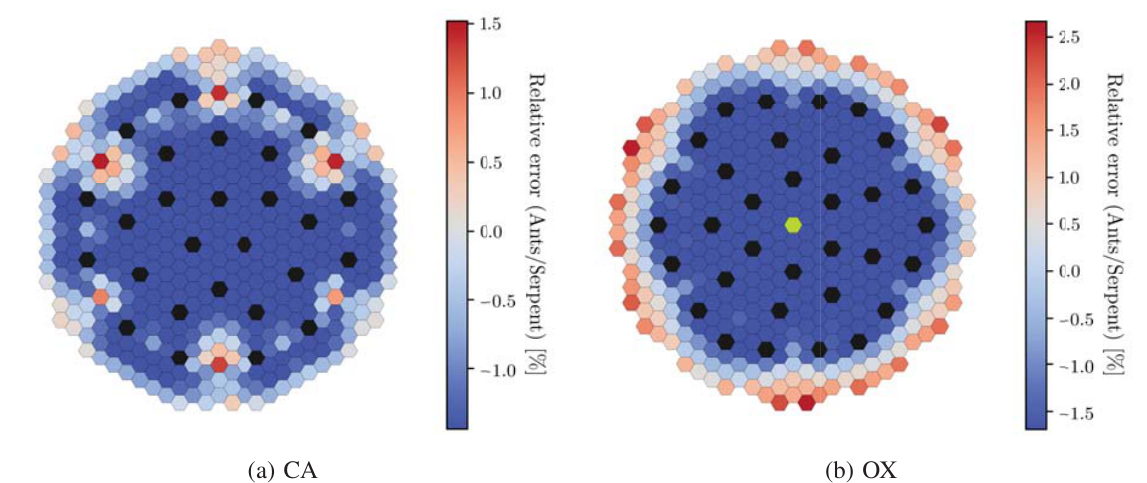
Figure 4: Comparison of Power Distributions in Criticality Case.